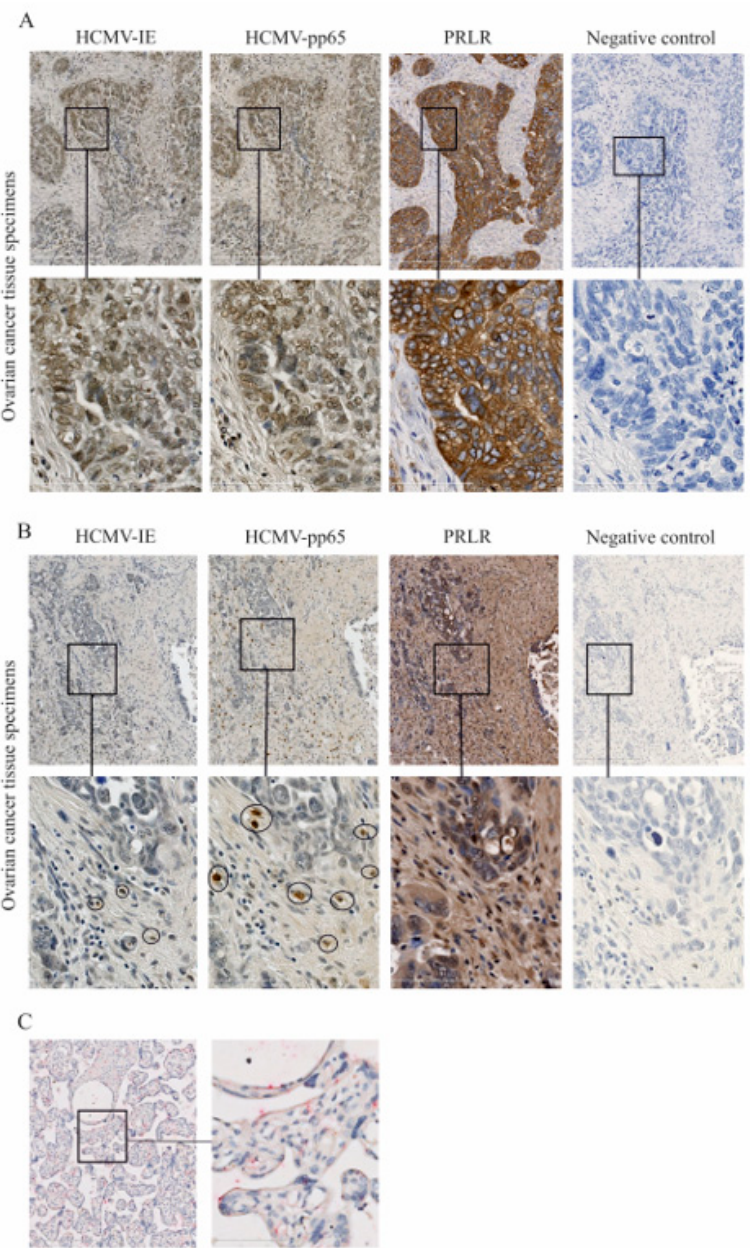
Figure 4. Expression of HCMV-IE, pp65, and prolactin receptor (PRLR) in ovarian tumor tissues. Expression of HCMV-IE, pp65, and PRLR proteins was monitored in ovarian tumor tissue specimens. ( A ) Extensive HCMV-IE, pp65, and PRLR were detected in a patient with serous adenocarcinoma and ( B ) focal expression of HCMV-IE and pp65 but extensive expression of PRLR were detected in another patient with serous adenocarcinoma. ( C ) HCMV-negative human placenta tissue was stained for HCMV-IE (brown color) and PRLR (red color). The lower row in the images shows the magnified area from images in the upper row. Scale bars: 50 µ